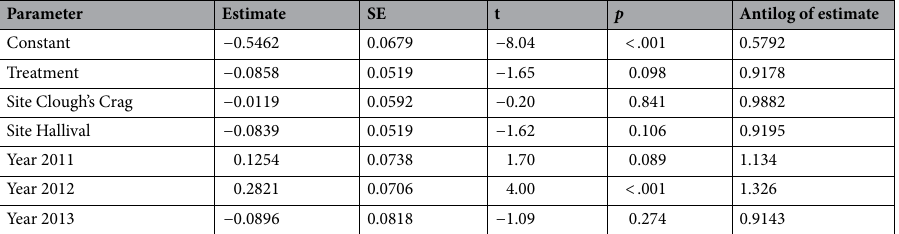
Table 5. Estimates of parameters from a Generalized Linear Model of the effect of rodenticide treatments (‘Treatment’), study site and year on the success of 1349 Manx shearwater nests on the Island of Rum between 2010 and